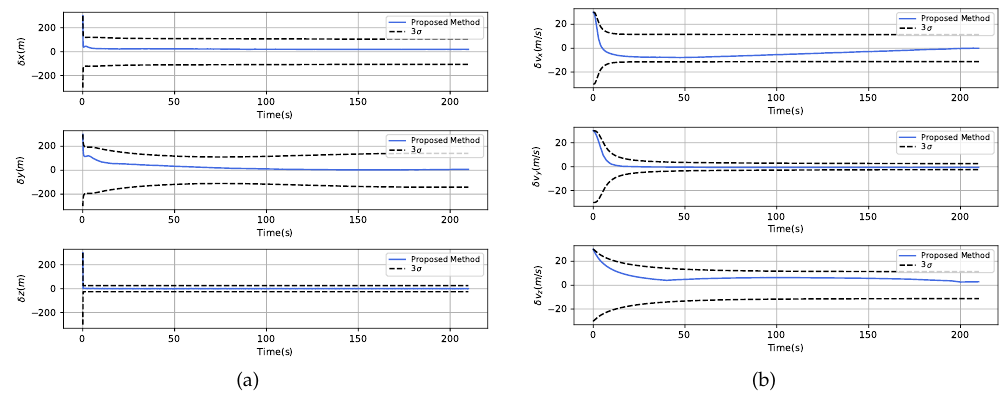
Figure 8. Estimation errors from the proposed tightly-coupled navigation scheme. ( a ) Triaxial position errors with 3 σ uncertainty bound. ( b ) Triaxial velocity errors with the 3 σ uncertainty bound.